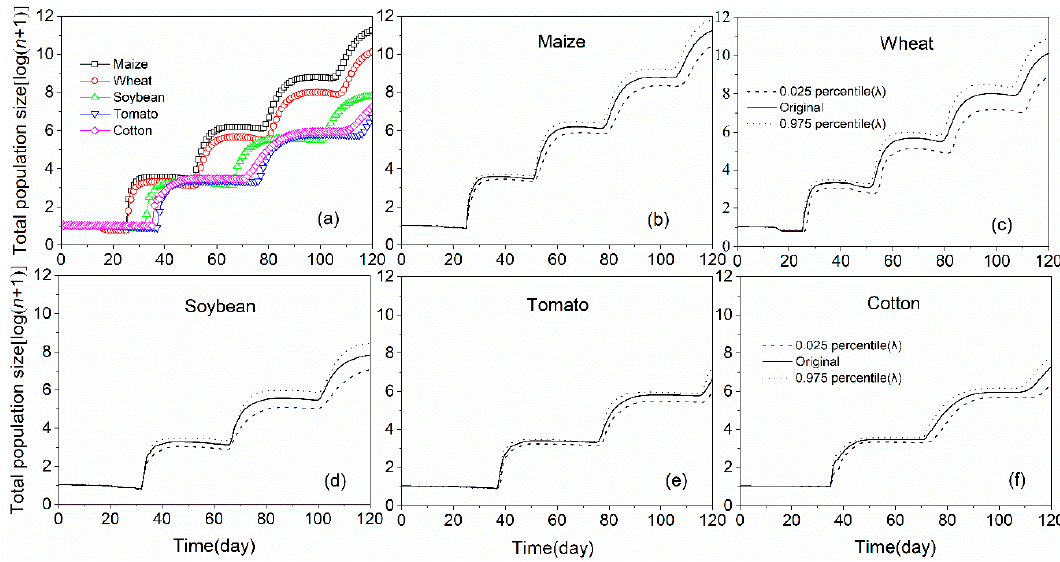
Figure 7. Projection of population growth potential of S. frugiperda fed on five plant species ( a ); the uncertainty of population projection of S. frugiperda fed on five plant species ( b – f ).